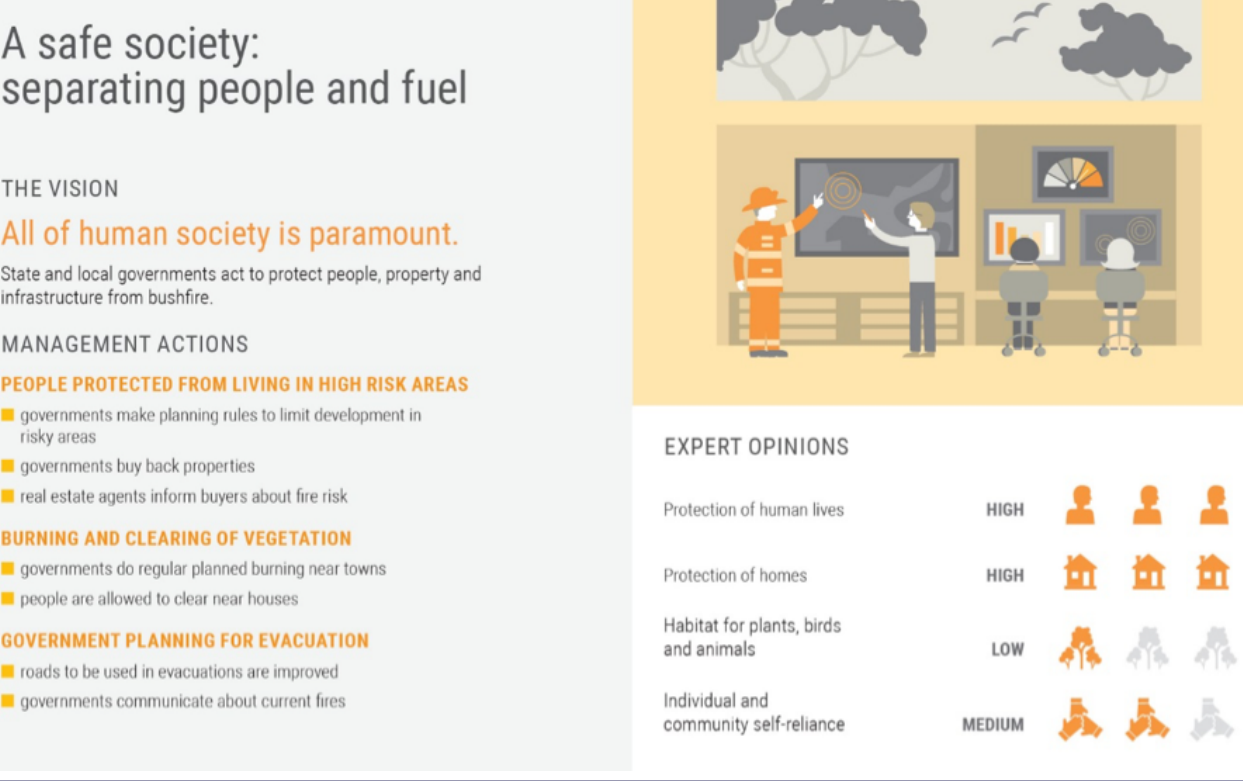
Fig. 7 . Illustration for “a safe society: separating people and fuel,” one of the three scenarios refined from those developed in workshops that were shown to post-workshop interview